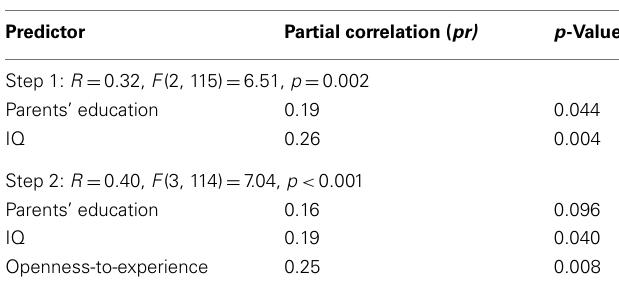
Table 2 | Results from hierarchical multiple regression in study 1